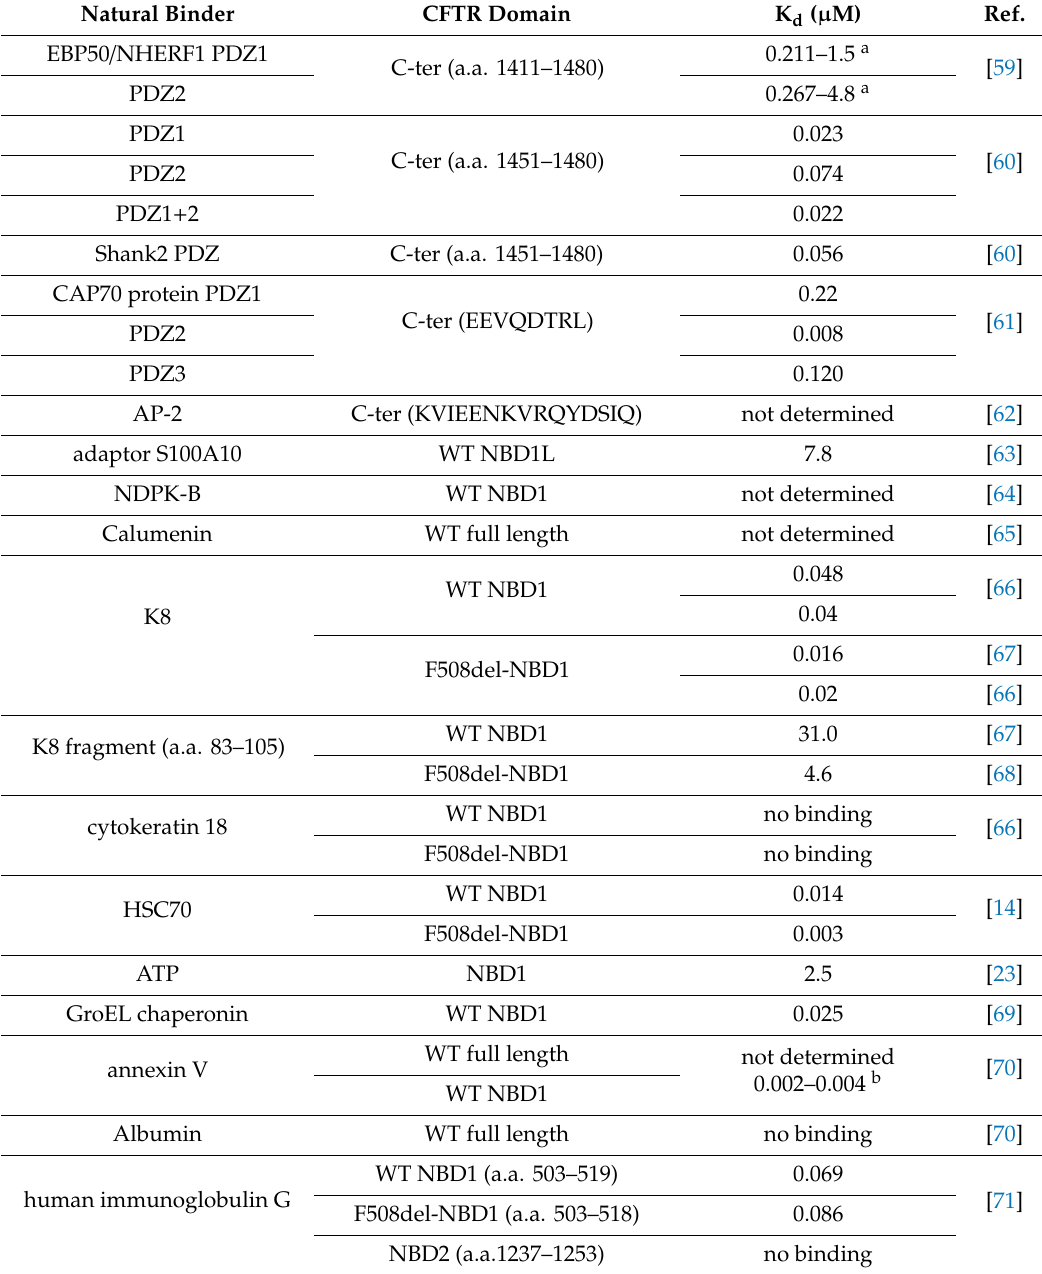
Table 3. List of physiological binders evaluated by SPR for their capacity to interact with